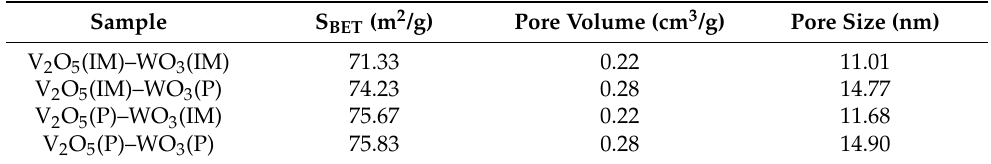
Figure 2. ( a ) X-ray diffraction patterns. ( b ) Raman spectra in the range of 1100 cm − 1 to 700 cm − 1 . ( c ) N 2 adsorption − desorption isotherms, and ( d ) Barrett–Joyner–Halenda (BJH) pore size distribution curves of V 2 O 5 (IM)–WO 3 (IM), V 2 O 5 (IM)–WO 3 (P), V 2 O 5 (P)–WO 3 (IM), and V 2 O 5 (P)–WO 3 (P). Table 2. Brunauer–Emmet–Teller (BET) results of V 2 O 5 (IM)–WO 3 (IM), V 2 O 5 (IM)–WO 3 (P), V 2 O 5 (P)– WO 3 (IM), and V 2 O 5 (P)–WO 3 (P).